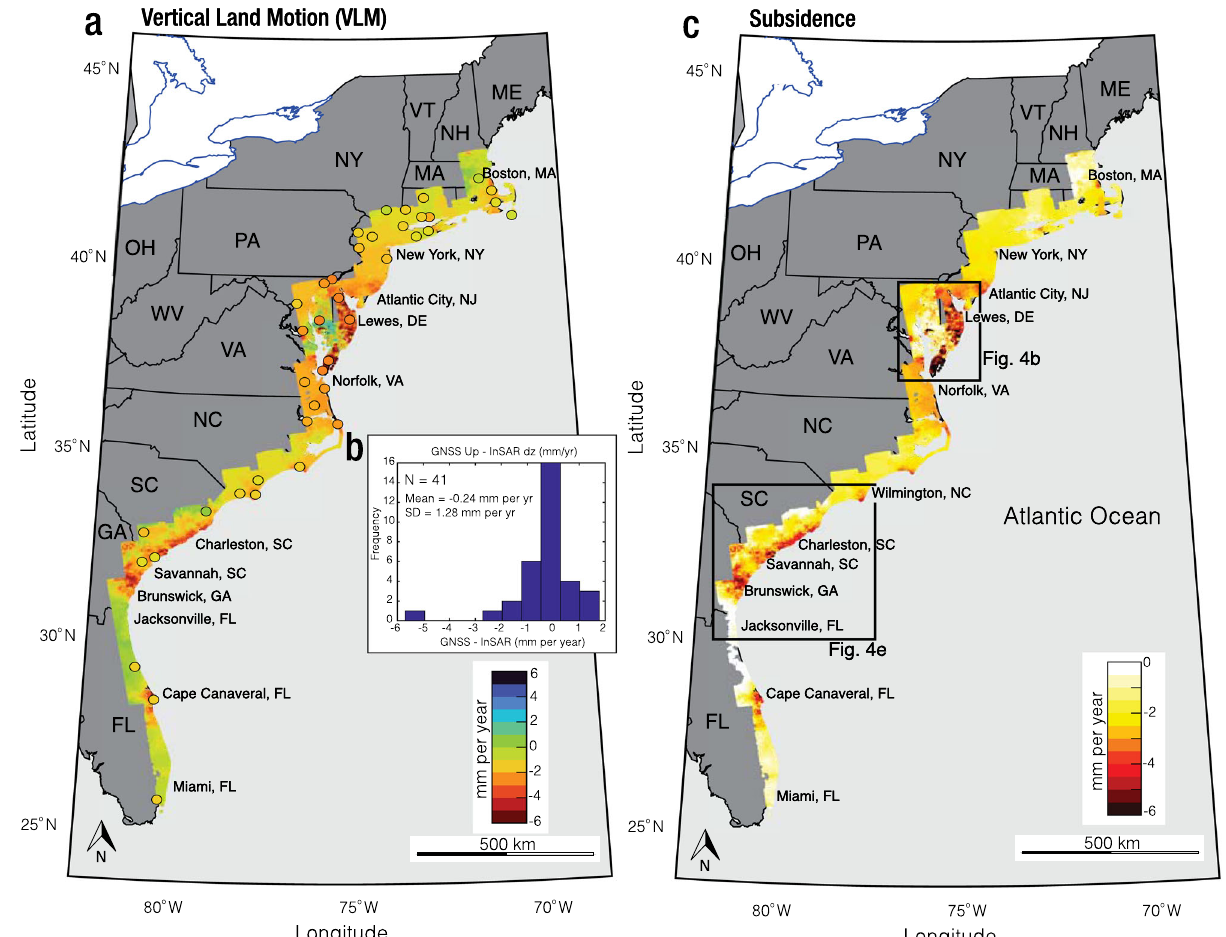
Fig.2|Verticallandmotion(VLM)acrosstheUSAtlanticcoast.a EstimatedVLM rate. The circles show the location of GNSS validation observations color-coded withtheirrespectiveverticalvelocities. b HistogramcomparingGNSSverticalrates with estimated VLM rates. The standard deviation (SD) of the difference between thetwodatasetsis1.3mmperyear. c Landsubsidence(representingnegativeVLM) acrosstheUSAtlanticCoast.Theblackrectanglesindicatetheextentofstudyareas for Chesapeake Bay area and Georgia, South Carolina, and North Carolina (GA-SC-